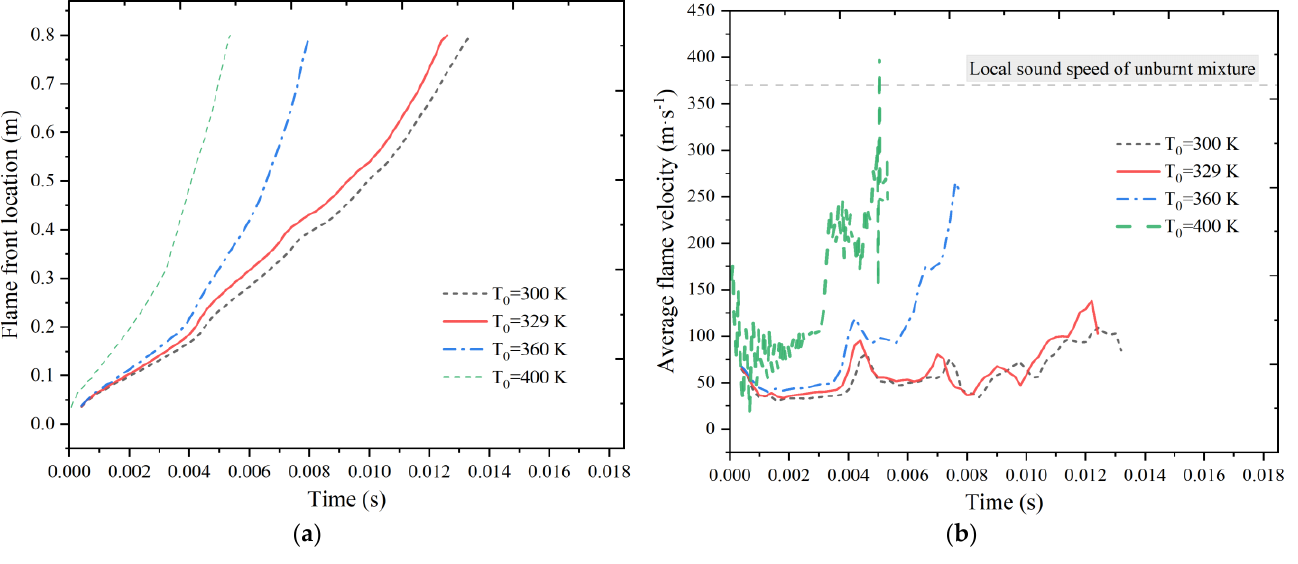
Figure 10. Effects of the initial temperature on the flame propagation process: ( a ) flame front position vs. time; ( b ) average flame velocity vs. time.